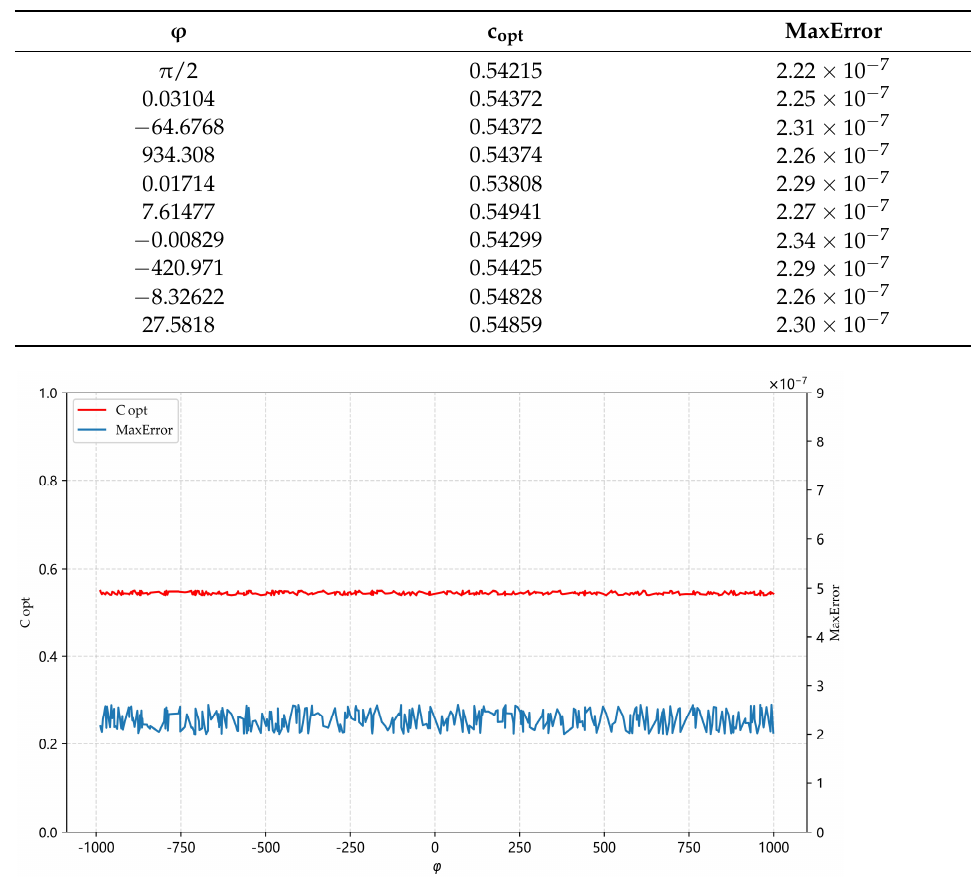
Figure 3. In fl uence of φ on interpolation. Figure 3. Influence of ϕ on interpolation.